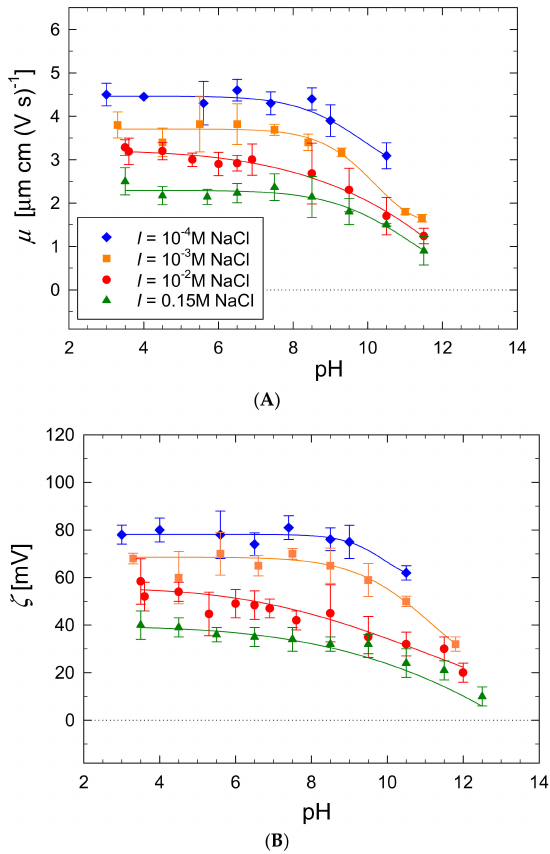
Figure 5. ( A ) Dependence of the electrophoretic mobility of the P-Arg molecule on pH (LDV) ( B ) Dependence of the zeta potential on pH. The measurements were performed at T = 298 K.